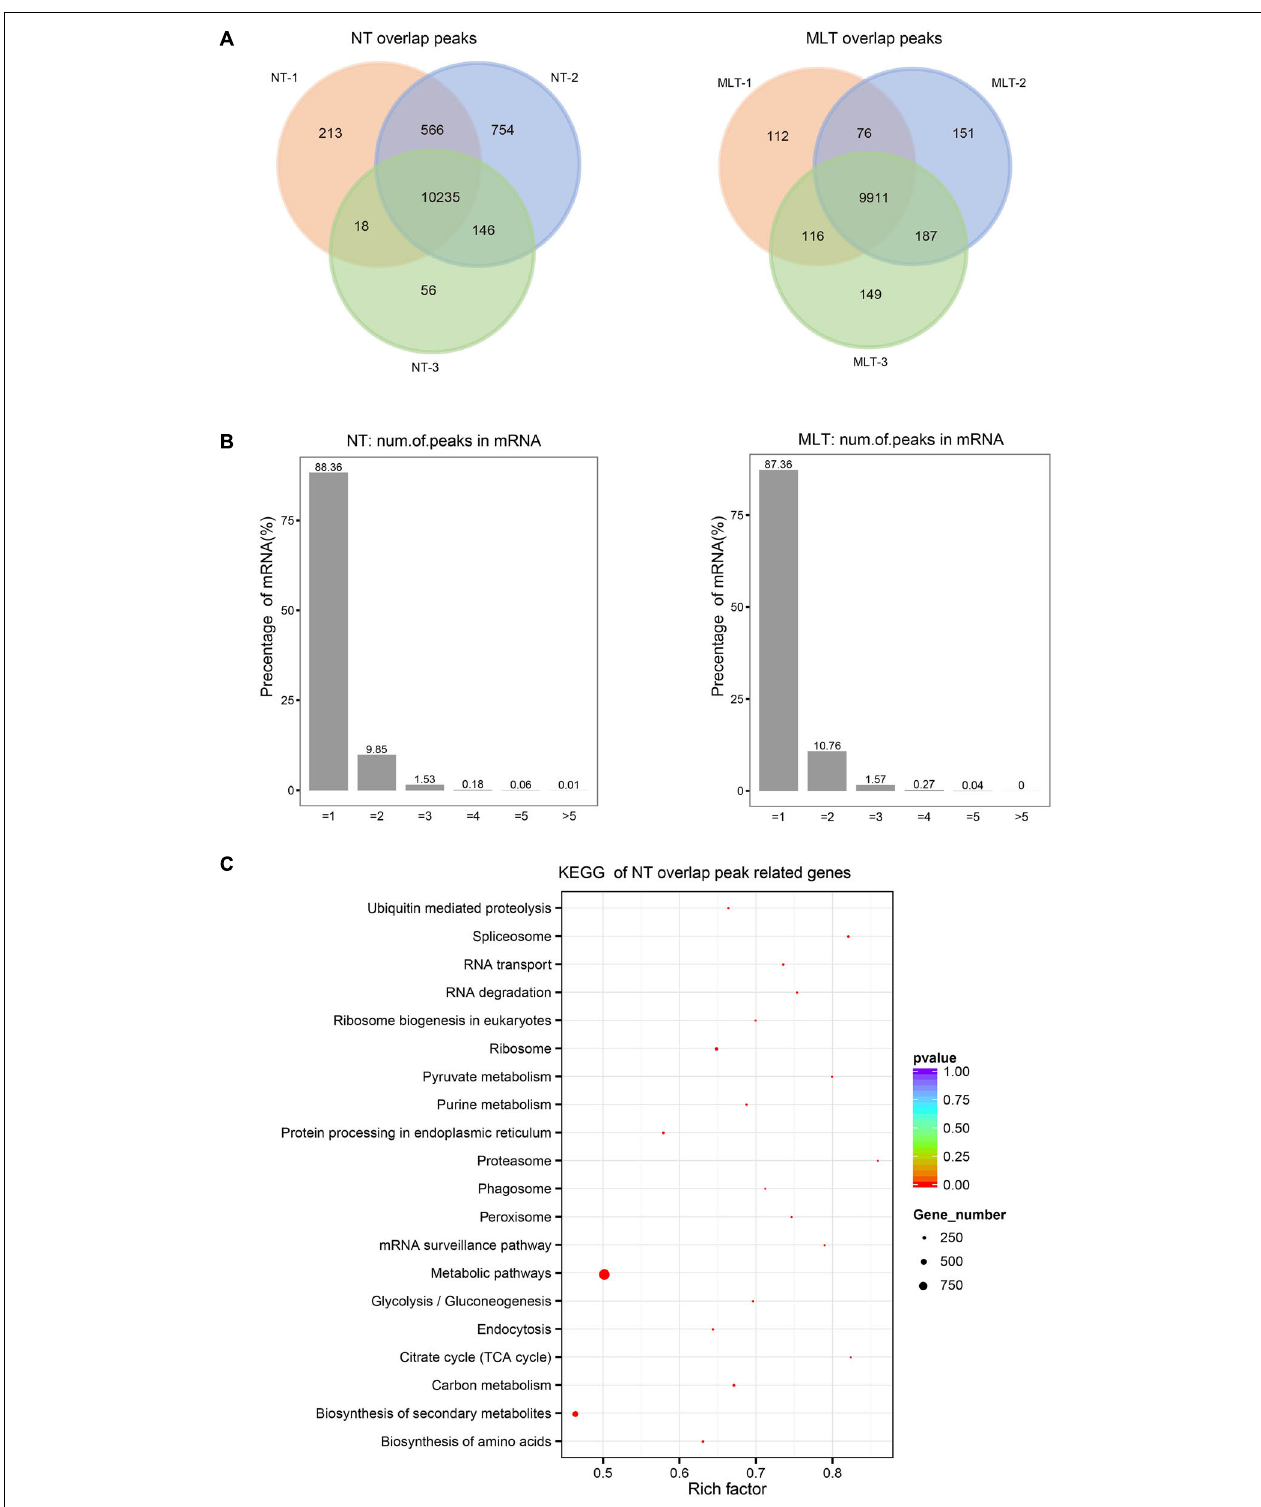
FIGURE 3 | Transcriptome-wide m 6 A methylation profiles in tomato anther at stage-II. (A) The number of overlapped m 6 A peaks identified in three biological replicates under NT and MLT conditions, respectively. The peaks identified in all three biological replicates were used for subsequent analysis. (B) Statistics on proportion of the m 6 A-modifited transcripts containing different m 6 A sites numbers in NT and MLT conditions. (C) KEGG enrichment analysis of all the transcripts with m 6 A peaks in NT condition.